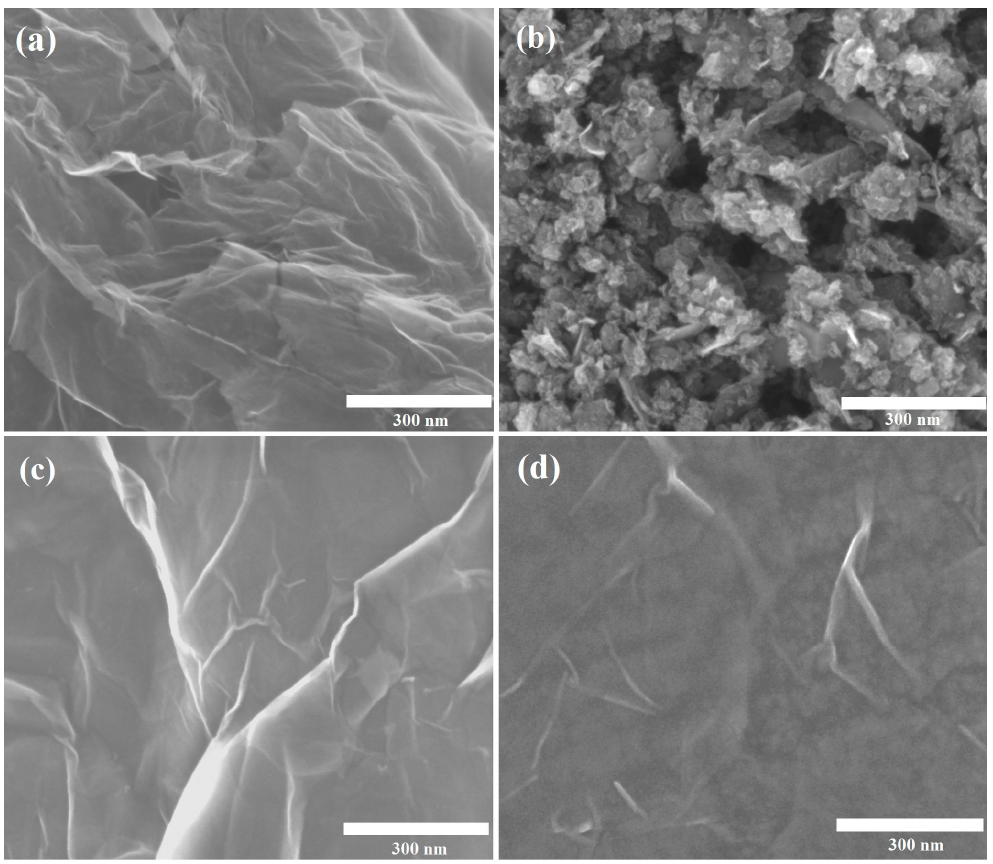
Figure 1. SEM (scanning electron microscopy ) images of: ( a ) graphene nanopowder (from Graphene Supermarket); ( b ) graphene nanoplatelet aggregates (from Strem Chemicals); ( c ) graphene oxide; and ( d ) reduced graphene oxide.